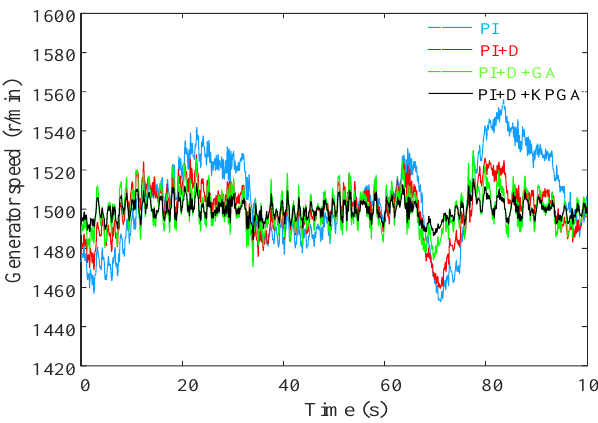
Figure 15. Change curve of generator speed.